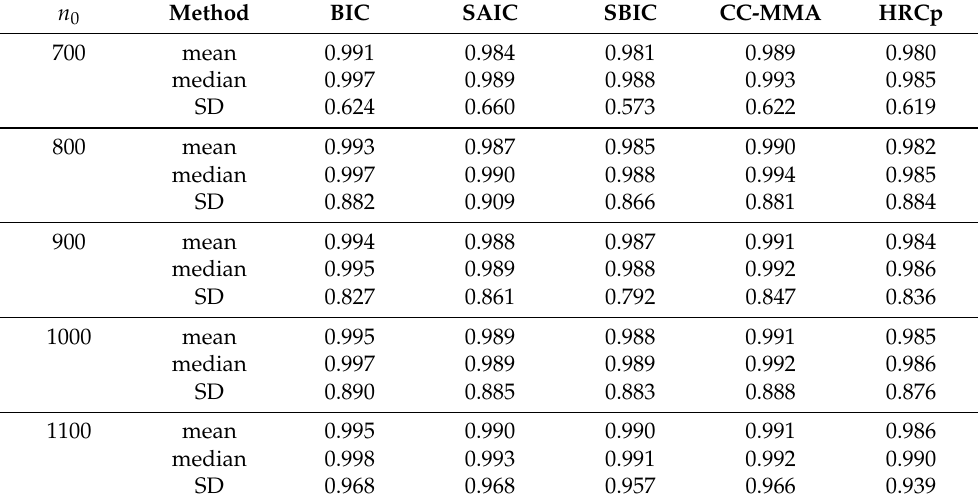
Table 3. The mean, median and SD of RMSPE across 500